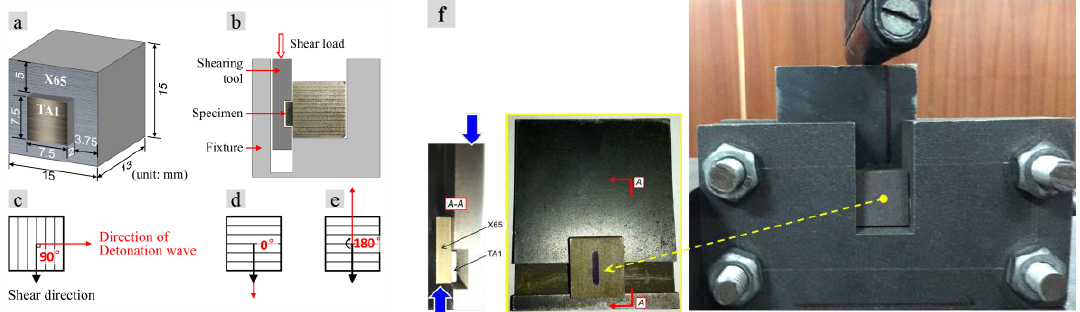
Figure 3. Schematic of: ( a ) the specimen size; ( b ) shear test; and ( c – e ) sampling schemes; ( f ) universal mechanical testing machine. Table 4. List of sample numbers in shear tests (repeated three times).